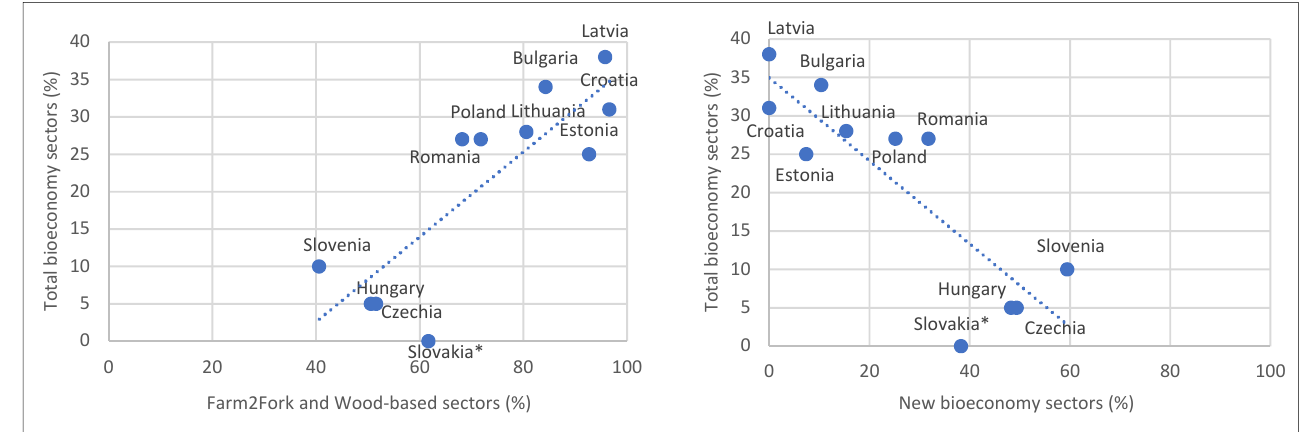
Figure 2. Share of (potentially) bio-based products among PRODCOM products that generate 50% of total value (y-axis) and the share of Farm2Fork and wood-based sectors (x-axis, on the left ) and novel sectors (x-axis, on the right ). * In Slovakia, non-bio-based products account for >50% of total value produced; here, 12 of the most important bio-based products are listed.